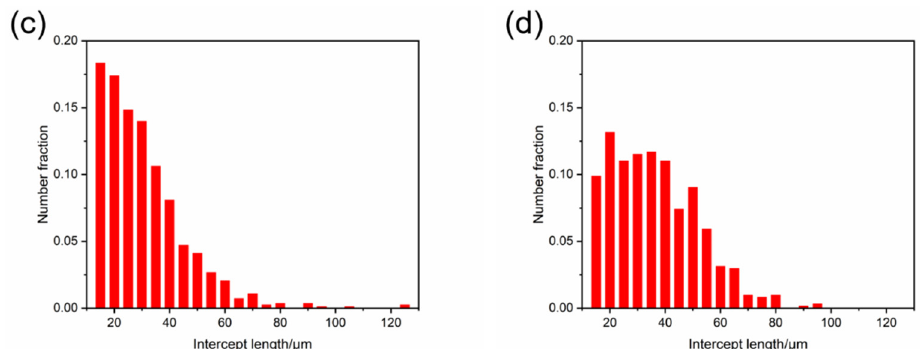
Figure 4. The EBSD images with all Euler angles and the grain size obtained by the EBSD technique of these HEAs, ( a , b ) the EBSD images with all Euler angles of Cr 5 and Mo 5 HEAs, ( c , d ) the grain size of the Cr 5 and the Mo 5 HEAs.